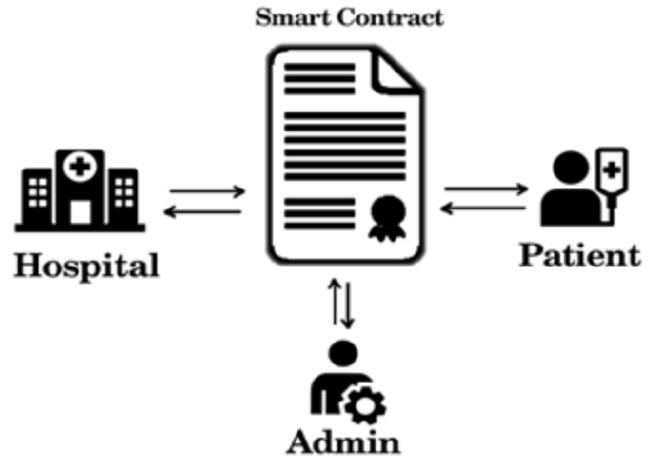
Figure 2. Basic Smart contract Framework for Electronic Healthcare Record